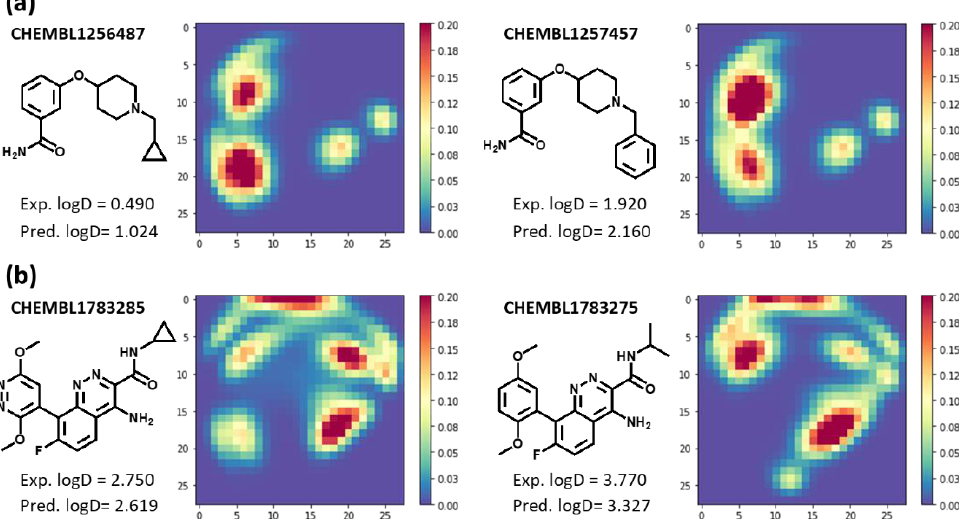
Figure 7. Relationship between MTM and its predicted molecular property ( a ) CHEMBL1256487 and CHEMBL 1257457. ( b ) CHEMBL1783285 and CHEMBL 1783275. Exp. logD means Experimental logD (at pH 7.4) and Pred. logD means Predicted logD (at pH 7.4). The compound identification numbers are ChEMBL [43] identification numbers.